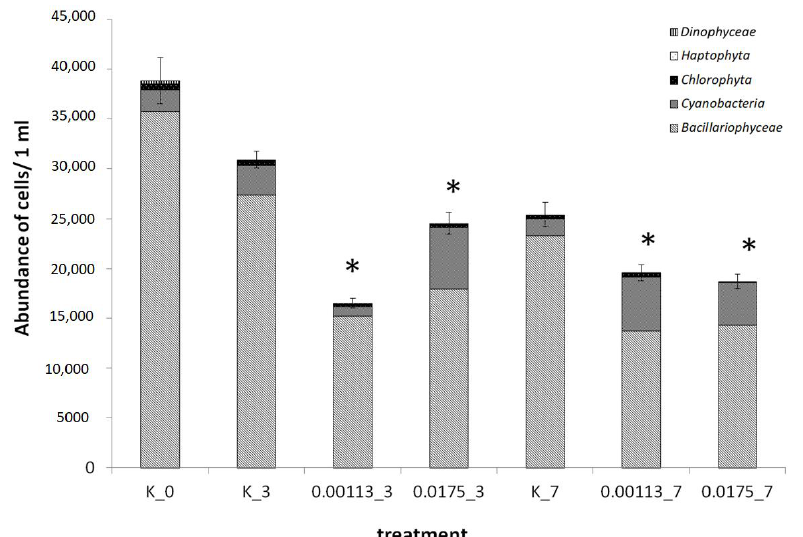
Figure 3. Abundance of microalgae. K indicates control cultures; the numbers 0.00113 and 0.0175 indicate cultures of lower (1.13 × 10 − 3 g · dm − 3 ) and higher (1.75 × 10 − 2 g · dm − 3 ) tested [BMIM]Cl concentrations, respectively. The number after the underline denotes the day of the experiment. Statistically significant differences were marked with the asterisk. In each case, the value from the experimental variant was compared with the value for the control sample on the same day ( p = 0.000002 for 0.00113_3 vs. K_3, p = 0.005617 for 0.0175_3 vs. K_3, p = 0.005178 for 0.00113_7 vs. K_7, p = 0.001357 for 0.0175_7 vs. K_7).